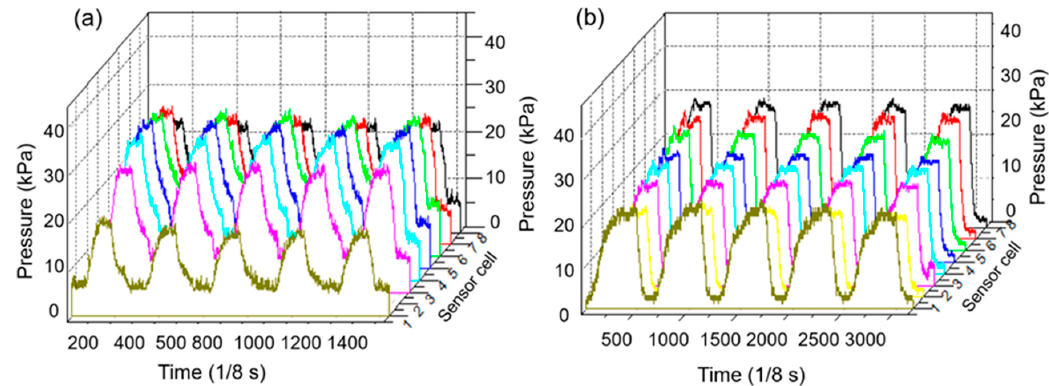
Figure 12. The interface pressures detected by one column of the sensor array under 5 continuous fast and slow compression cycles in treatment. ( a ) Faster compression cycles; ( b ) Slower compression cycles.